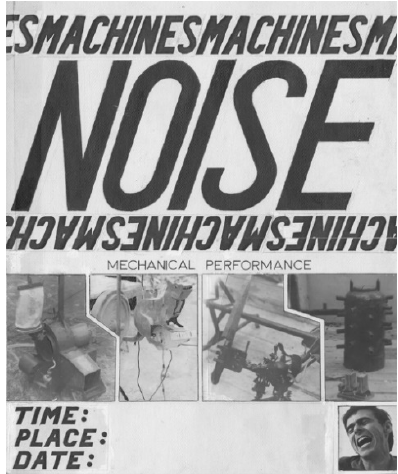
Figure 1. Poster for Noise , a mechanical performance by SRL, 21 September 1979, Golden Gate Park Bandshell, San Francisco. © Survival Research Labs (www.srl.org).